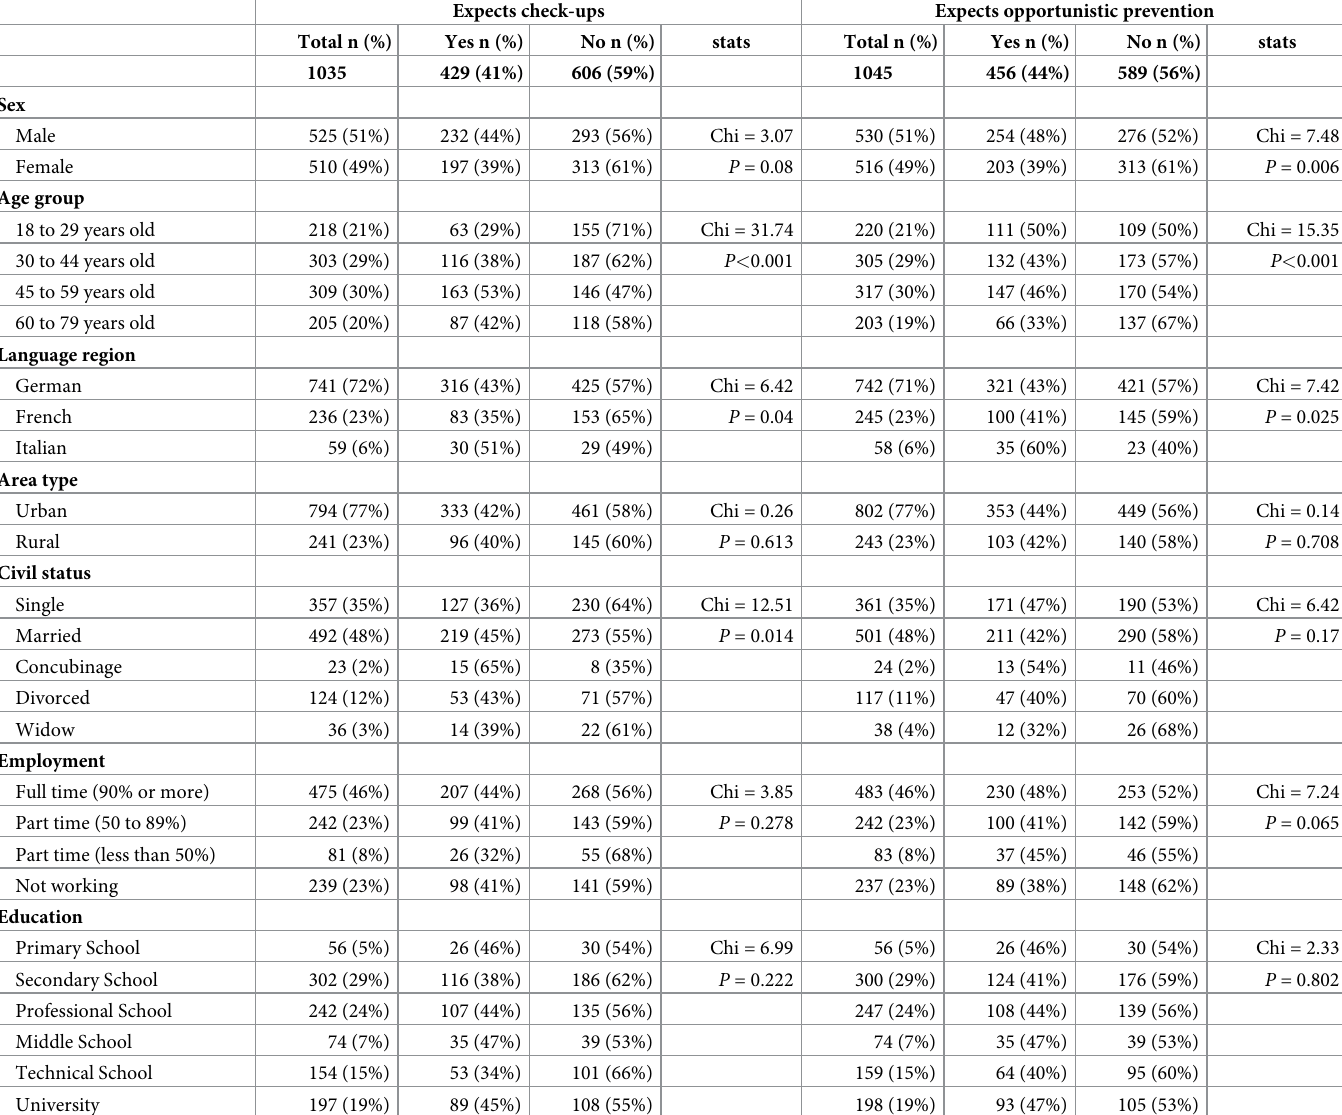
Table 1. Frequency of expectations of check-ups and opportunistic prevention across general demographic characteristics. Expects check-ups Expects opportunistic